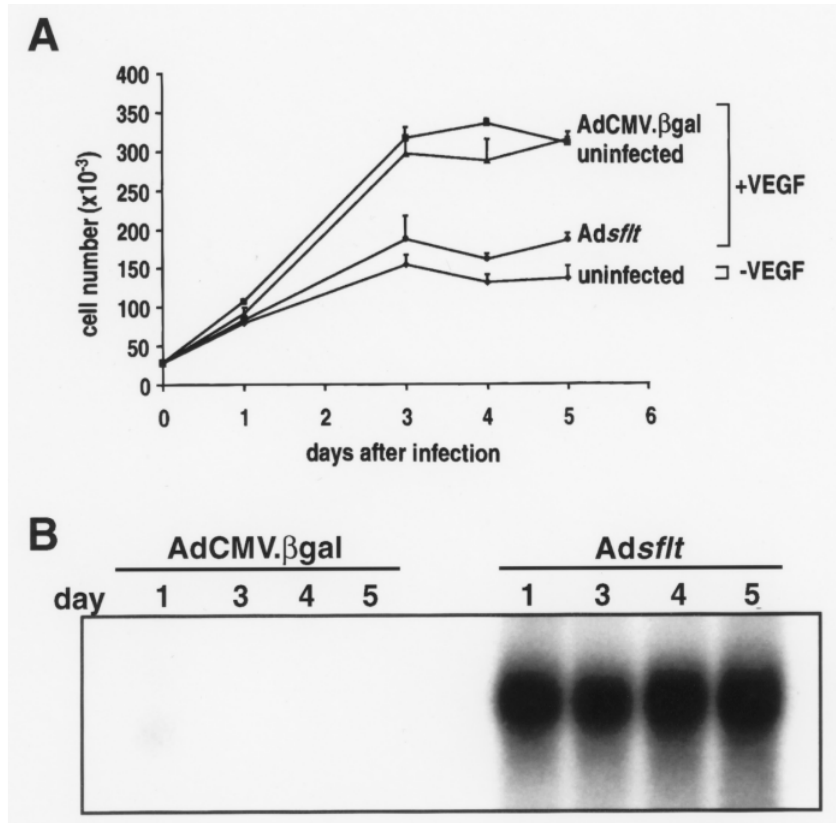
Figure 1. Ad sflt -mediated sFLT-1 overexpression inhibits VEGF-induced HUVEC proliferation in vitro. ( A ) Effect of Ad sflt infection on HUVEC proliferation in vitro. HUVEC (2.5 × 10 4 ) grown in the AdCMV. β gal (squares) or Ad sflt (circles). Uninfected HUVEC grown in the absence of VEGF (dia-